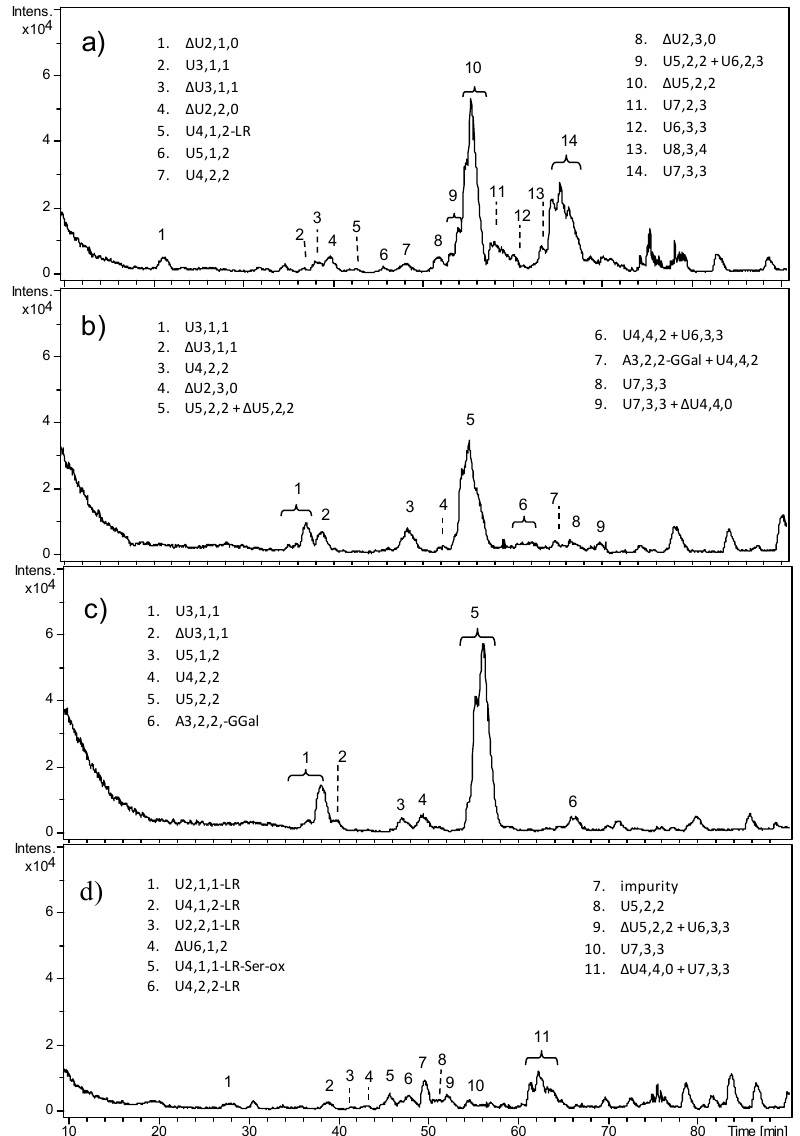
Figure 3. LC–MS profiles of heparinase digestion products from fetal HS: ( a ) FT1, ( b ) FT2, ( c ) FT3, and ( d ) FT4. Oligosaccharides were identified based on their mass/charge ratio ( m / z ) and labeled as follows: ∆ indicates the unsaturated bond of the terminal uronic acid, followed by the number of monomers, sulfate groups, and acetyl groups. When a uronic acid (or a glucosamine) is present at both the reducing end (RE) and non-reducing end (NRE), it is indicated by U (or A). LR indicates the tetrasaccharide G-Gal 2 -Xyl of the linkage region. LR-Ser-ox indicates the presence of the linkage region bearing an oxidized serine residue.